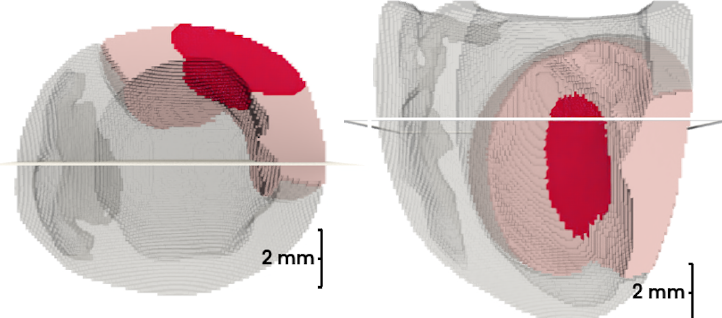
Figure 2. Anatomical model of the rat ventricles with a post-infarction scar. The border zone is colored in pink and the scar is in red.